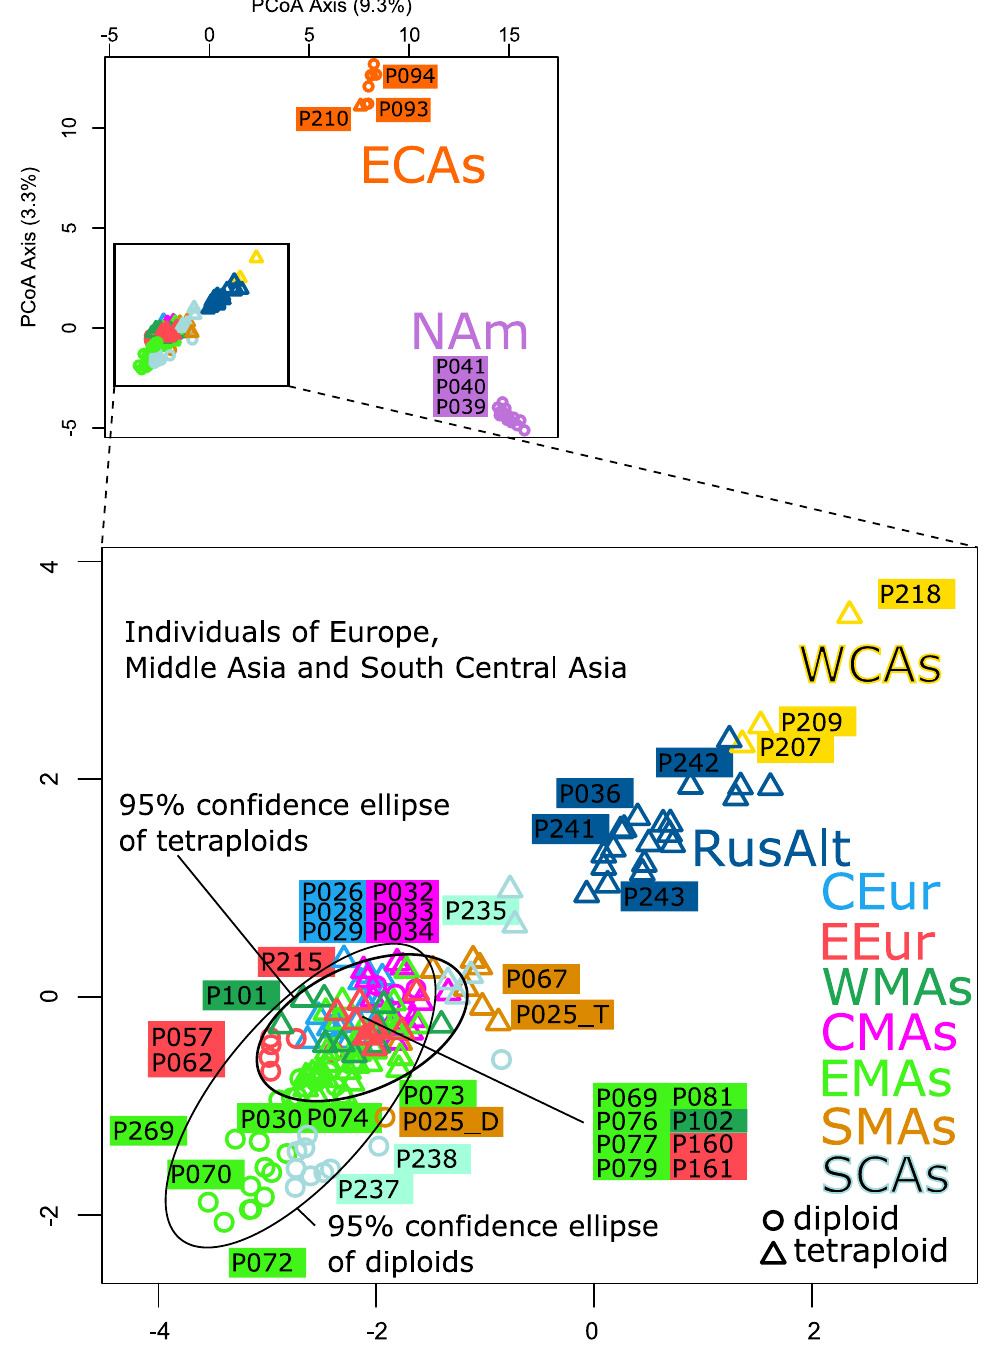
Figure 5. PCoA scatterplot. Symbols representing samples of the same geographical area were coloured according to Fig. 1. Circles indicate diploids, triangle tetraploids. Upper graph: Distinct from most of the samples, the populations of eastern Central Asia and North America each form their own clusters. Lower graph: Within the remaining populations, those from the western Central Asia and from the Russian Altai are genetically distinct. Within the densely scattered other populations, there is a trend visible, which separates diploids and tetraploids from each other. The figure was generated in R using the packages ‘MASS’ (http:// www. stats. ox. ac. uk/ pub/ MASS4/), ‘car’ (https:// socia lscie nces. mcmas ter. ca/ jfox/ Books/ Compa nion/) and ‘graphics’ (https:// www. rdocu menta tion. org/ packa ges/ graph ics) and was edited in Inkscape v1.0.2 (https:// inksc ape.